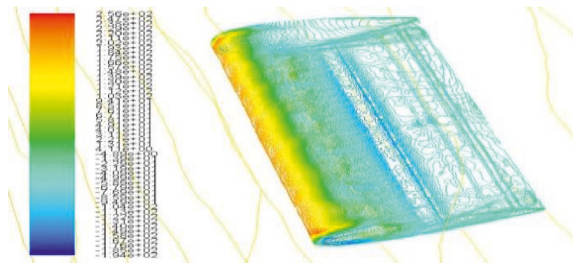
Figure 12: Total pressure at 10 ° AOA for the 2nd module.